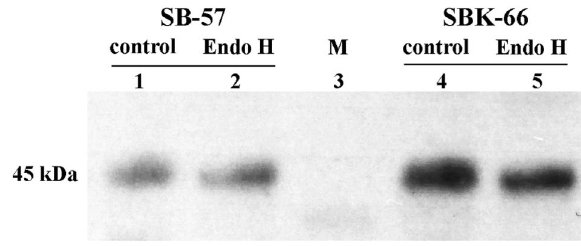
Figure 8. Western blot analysis of rhIGFBP-3 digested by Endo H in transgenic rice seeds. Total protein was extracted from mature dehulled seeds of SB-57 and SBK-66 transgenic lines and digested by Endo H. Lane 1: SB-57; lane 2: SB-57 digested by Endo H; lane 3: marker; lane 4: SBK-66; and